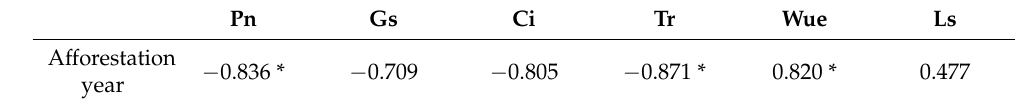
Figure 4. Regression fi tt ing diagram of gs and SWC.